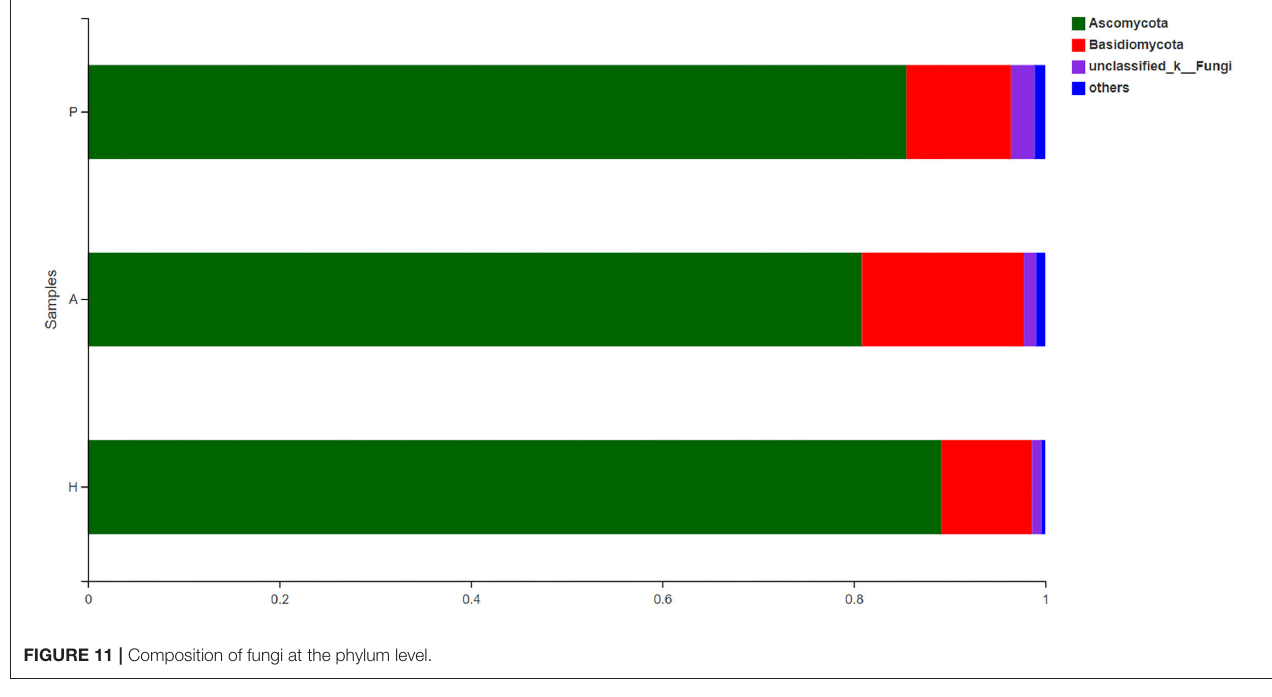
FIGURE 11 | Composition of fungi at the phylum level.